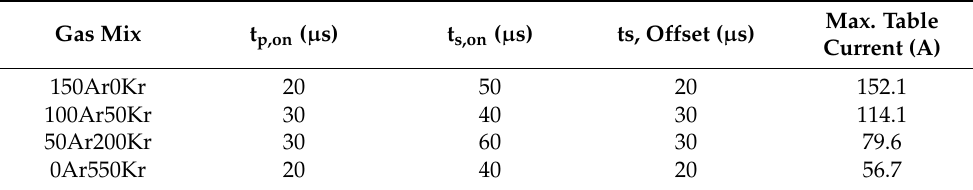
Table 4. Highest values of the maximum table currents. All measurements were executed with a 500 Hz HiPIMS frequency.